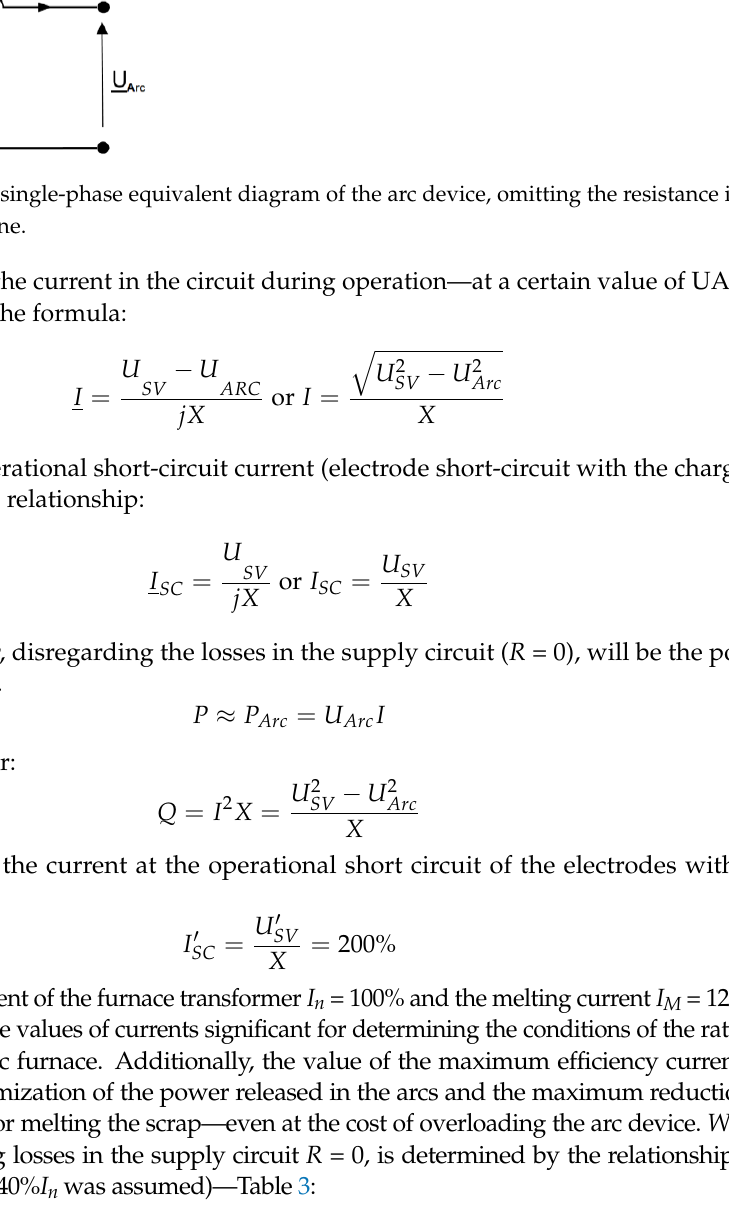
Figure 7. Changes in the k q factor of the power–voltage characteristics for different arc supply re- sistances, as a function of the current consumed by the arc device.